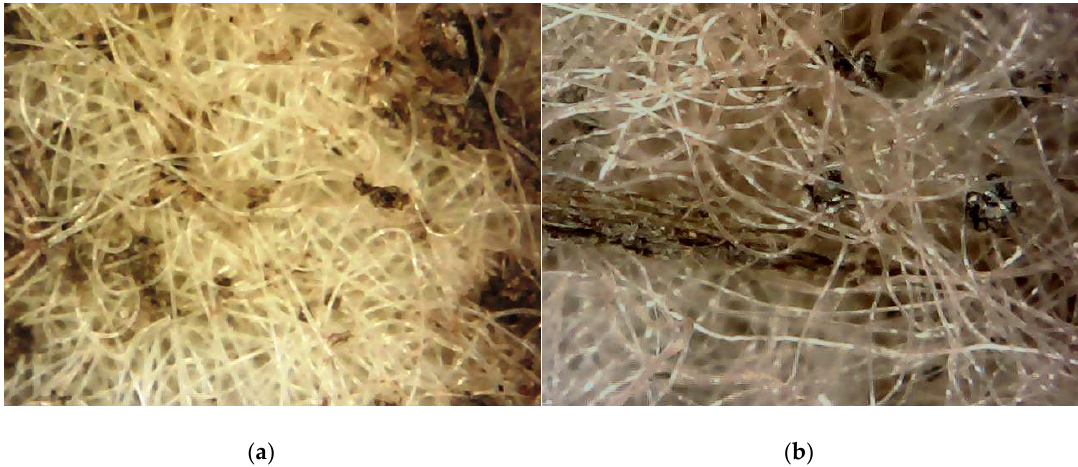
Figure 1. Geotextile materials after 12 months of testing under natural conditions: ( a ) colmatage after testing; ( b ) penetration of plant roots after testing.